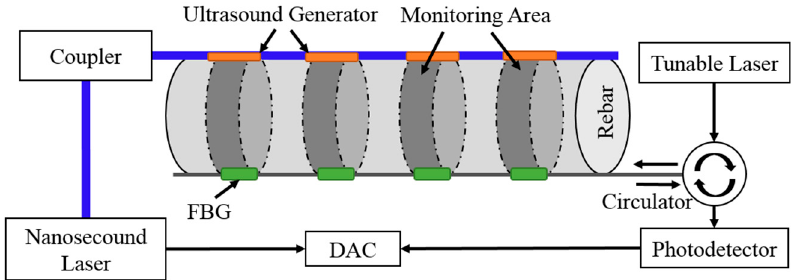
Figure 4. Setup of distributed ultrasound corrosion monitoring.